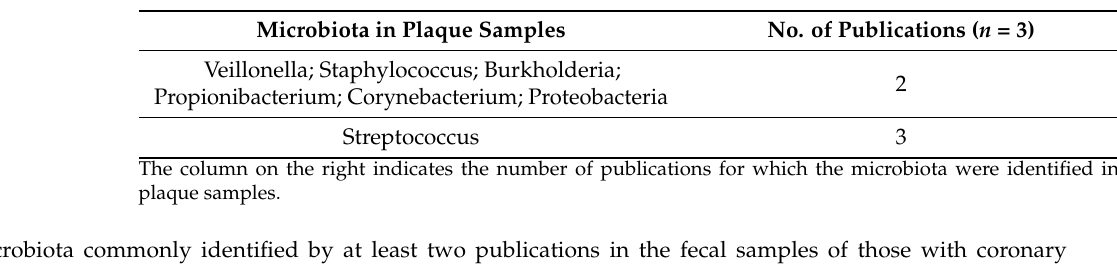
Table 2. Microbiota commonly identified by at least two publications in the atherosclerotic plaque samples of those with coronary heart disease.